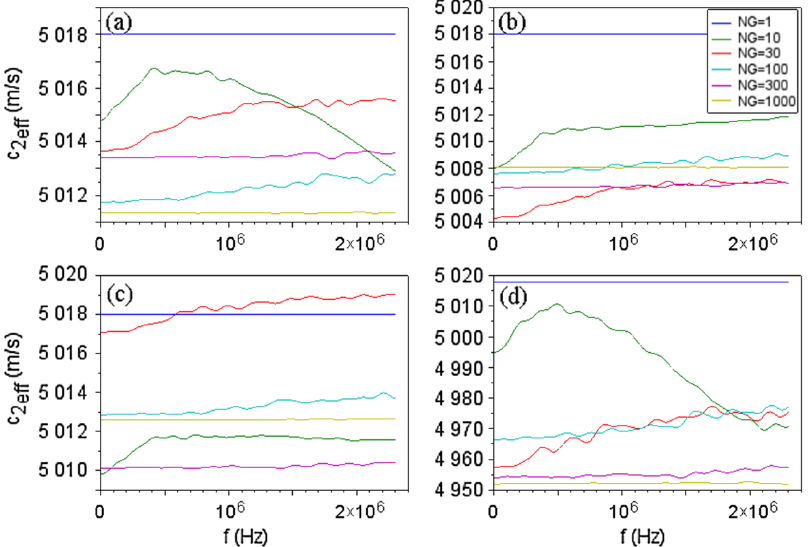
Figure 7. Effective sound velocities in layer 2 as the function of frequency obtained with the velocity surfaces in Figure 6, for different grain number N G along fibers. The case N G = 1 is for the homogeneous (monocrystalline) layer 2. The legend applies to all graphs. ( a – d ) correspond to Equations (9a)–(9d) respectively.